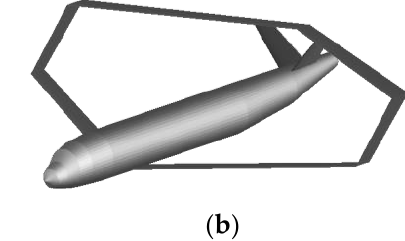
Figure 3. ( a ) Strut-braced and ( b ) box wing configurations designed in OpenVSP based on A320 design (adapted from [24]).